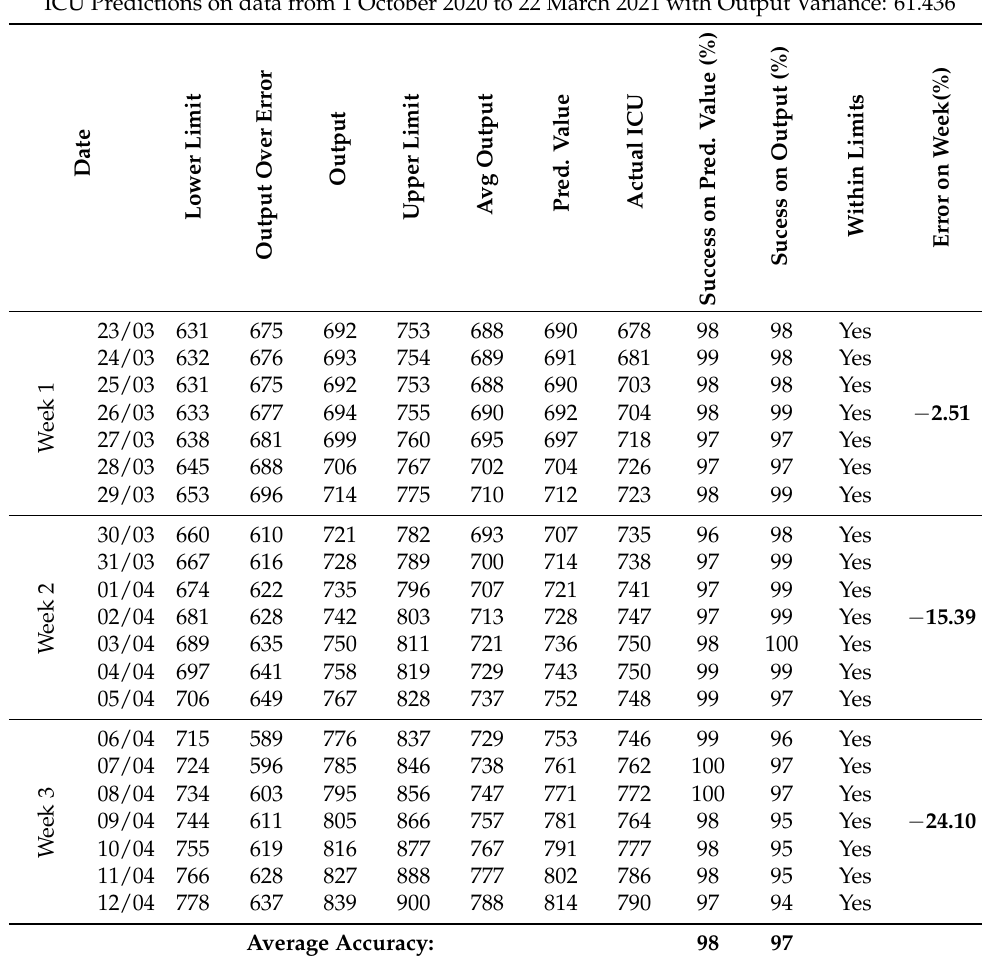
Table A1. ARTXP and ARIMA model Predictions sing error